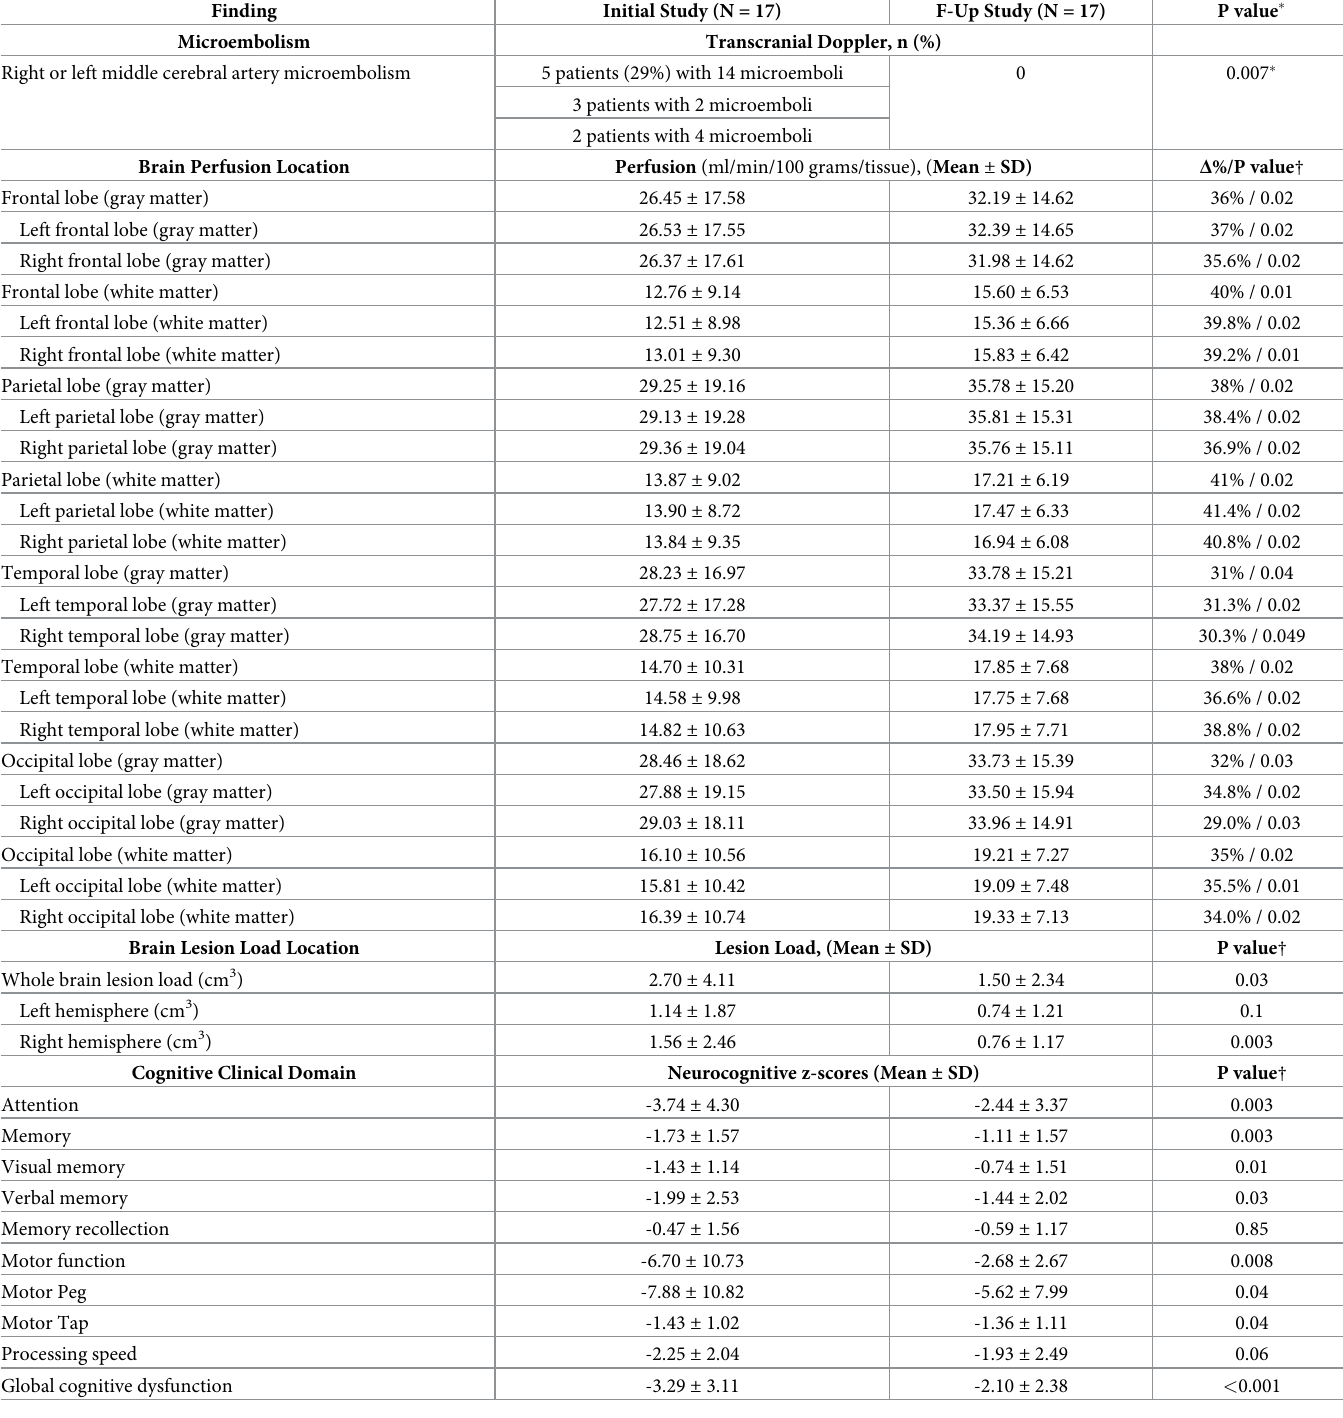
Table 5. Effect of medical therapy in patients with acute cerebrovascular